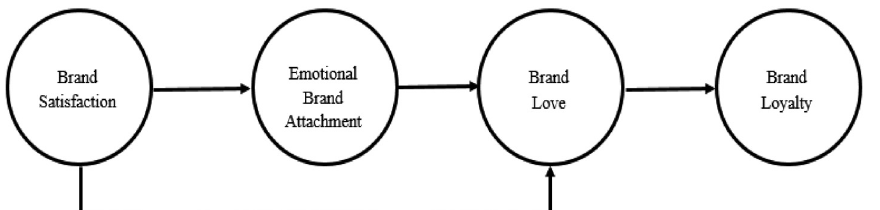
Figure 3. Research fi nal